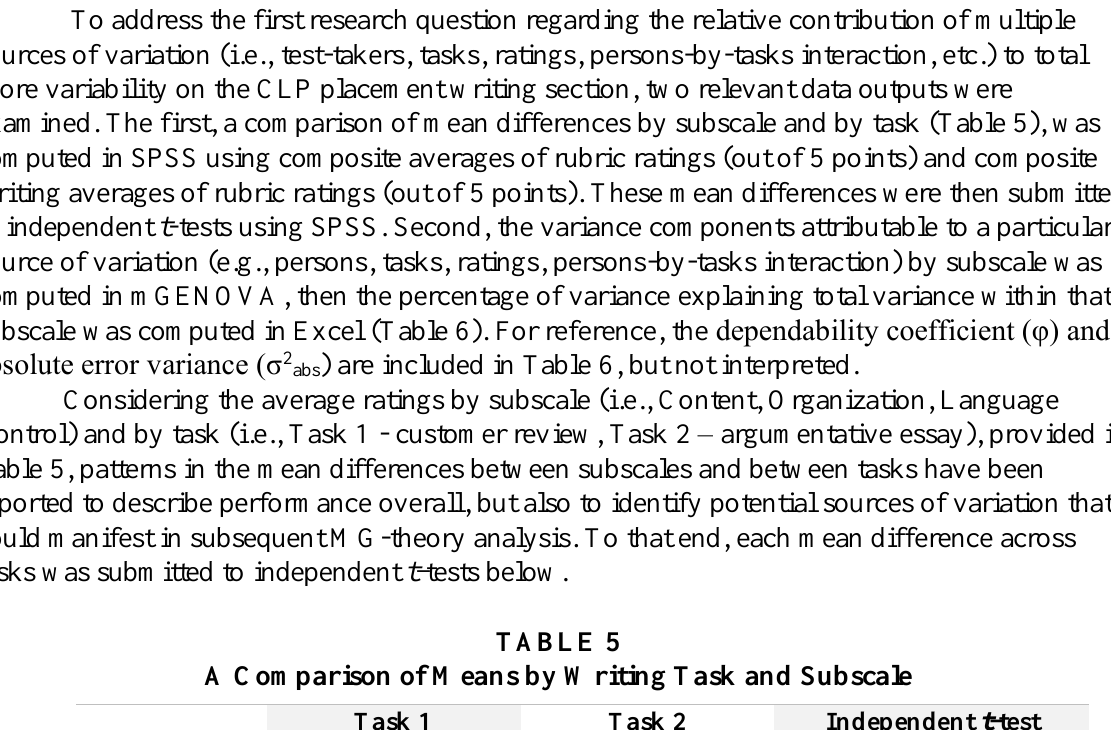
A Comparison of Means by Writing Task and Subscale